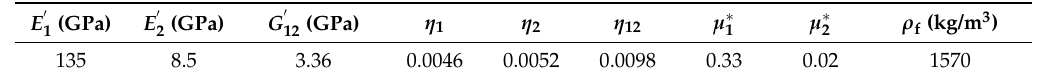
Table 2. The material property of